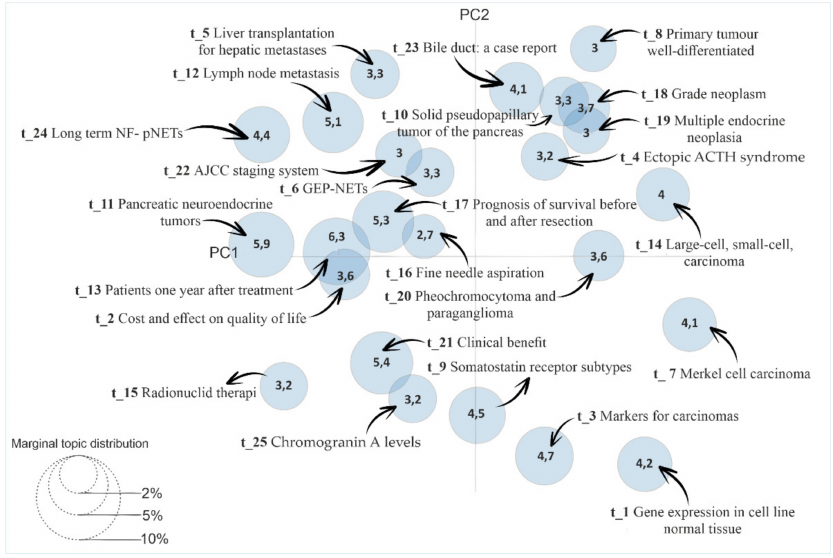
Figure 8. Identification of relationships among topics from the LDAvis Method.